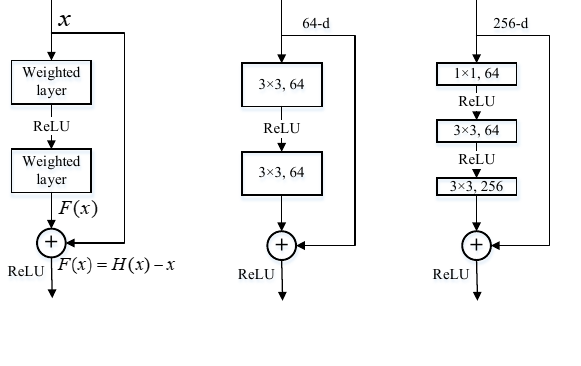
Figure 2. Base residual block